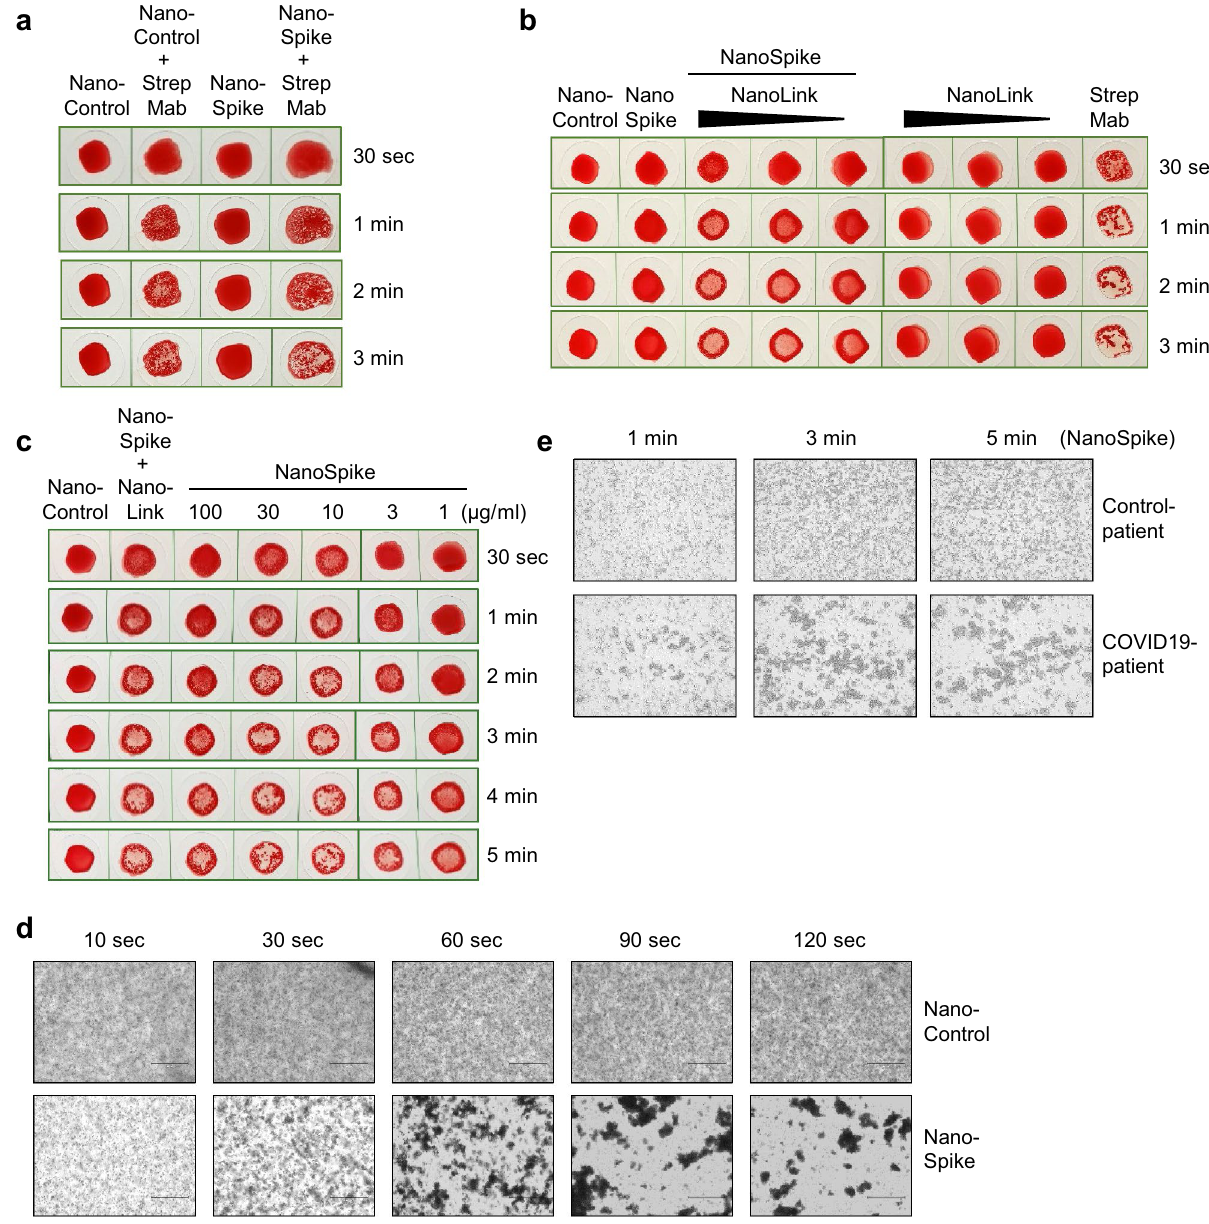
Figure 3. Functional activity of recombinant proteins detecting SARS-CoV-2-specfic AB. ( a ) Hemagglutination assay of whole EDTA blood that was treated with NanoControl or NanoSpike protein (30 µg/ml) in the presence or absence of AB against the Strep-tag. ( b ) Hemagglutination assay of blood that was treated with NanoSpike (30 µg/ml) in the absence or presence of NanoLink at concentrations corresponding to a molar ratio of NanoSpike-to-NanoLink of 9:1, 3:1 and 1:1. Blood treated with NanoLink, NanoControl, NanoSpike or a combination of NanoSpike and αStrep AB is shown for comparison. Time points indicate the duration of agglutination. ( c ) Hemagglutination assay of blood from a convalescent COVID-19 patient that was treated with indicated concentrations of NanoSpike ( c ) or NanoNuc ( d ). Samples treated with NanoControl (30 µg/ ml) or NanoSpike (30 µg/ml) plus NanoLink (14.3 µg/ml) serve as controls. Time points indicate the duration of agglutination. ( d ) Phase contrast microscopy of blood from a convalescent COVID-19-patient that was incubated with NanoControl and NanoSpike. ( e ) Phase contrast microscopy of blood from a convalescent COVID-19-patient and a COVID-19-negative control patient, which was incubated with